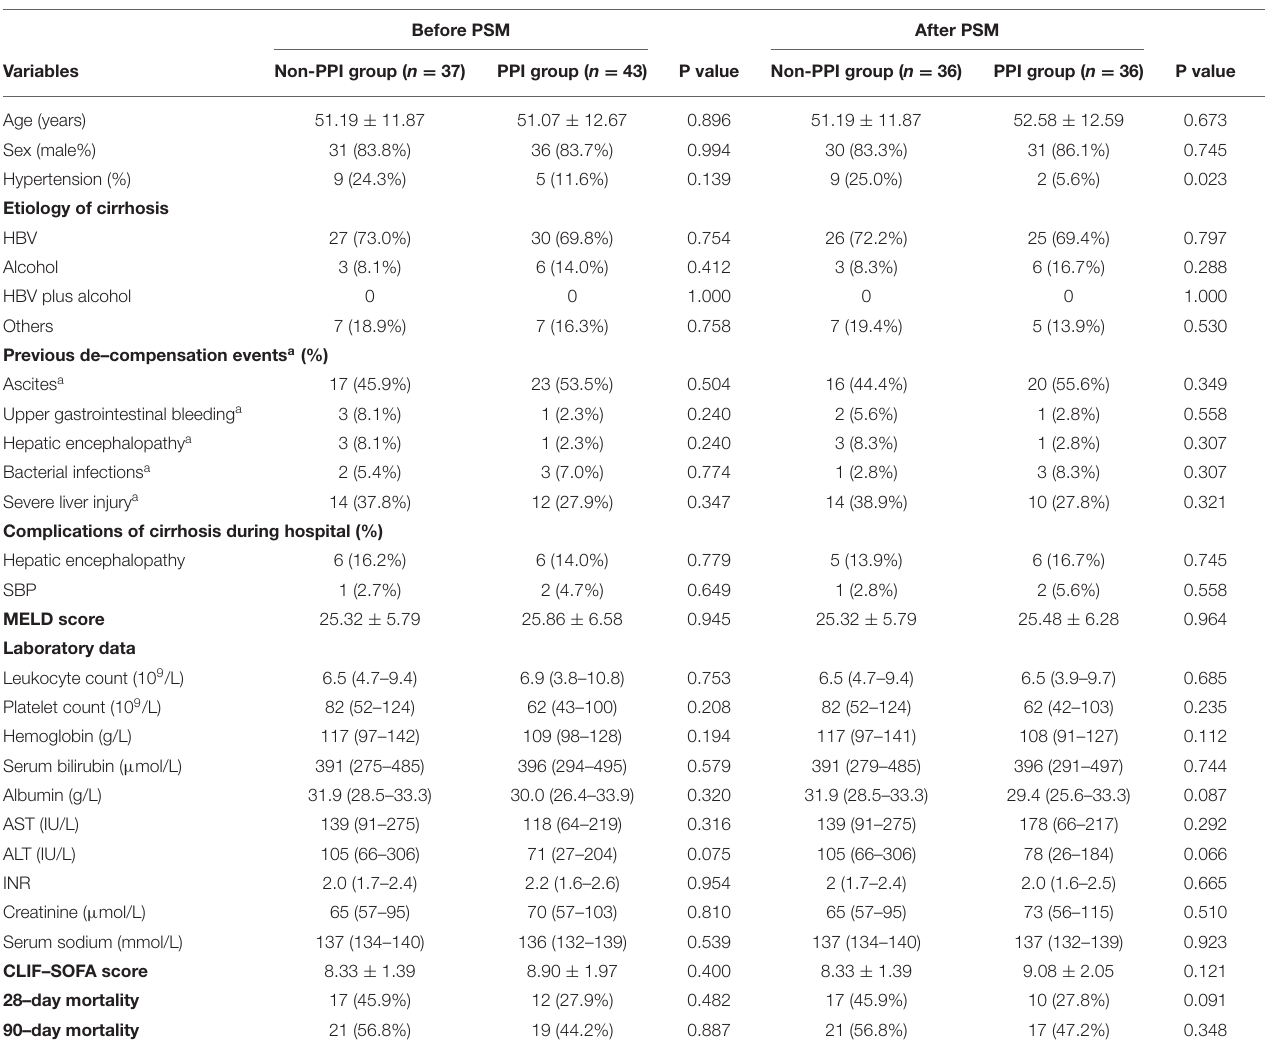
TABLE 2 | Baseline characteristics of ACLF patients receiving and not receiving PPI